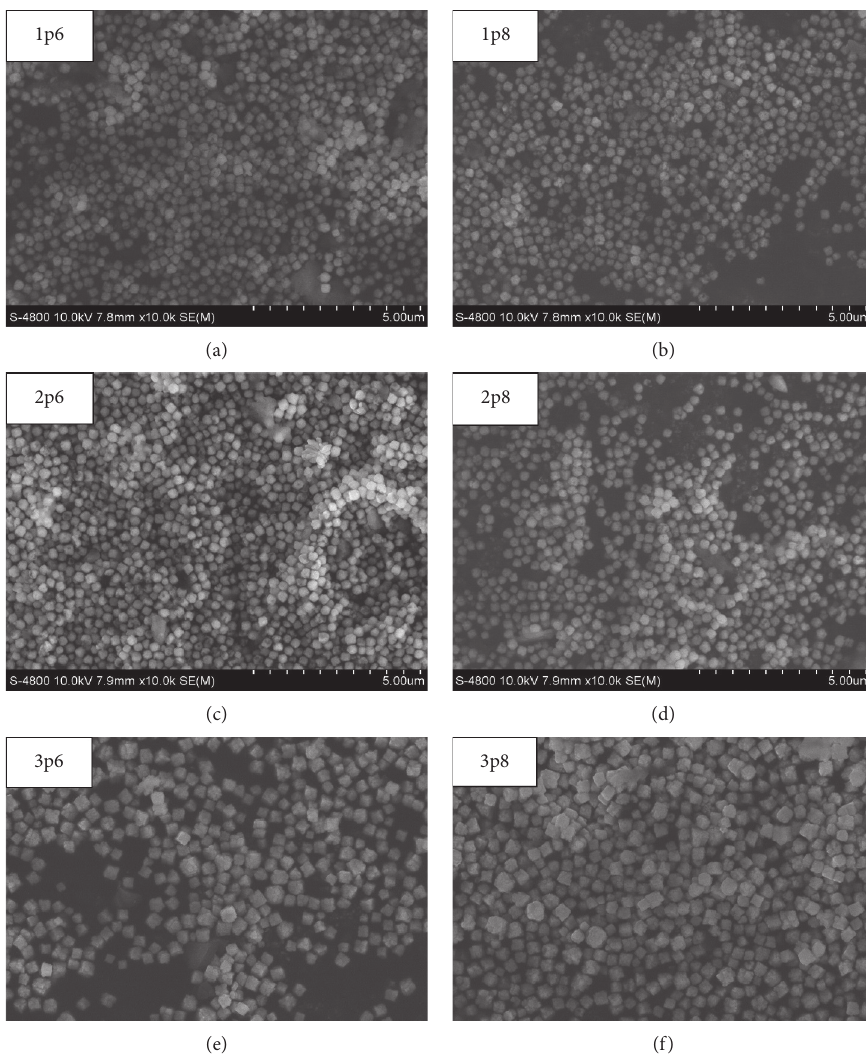
Figure 2: FE-SEM micrographs of Cu 2 O samples at 5 μ m scale (10,000x magnification): (a) 1 p 6, (b) 1 p 8, (c) 2 p 6, (d) 2 p 8, (e) 3 p 6, and (f) 3 p Table 2: Particle sizes (mean ± standard deviation) of the Cu